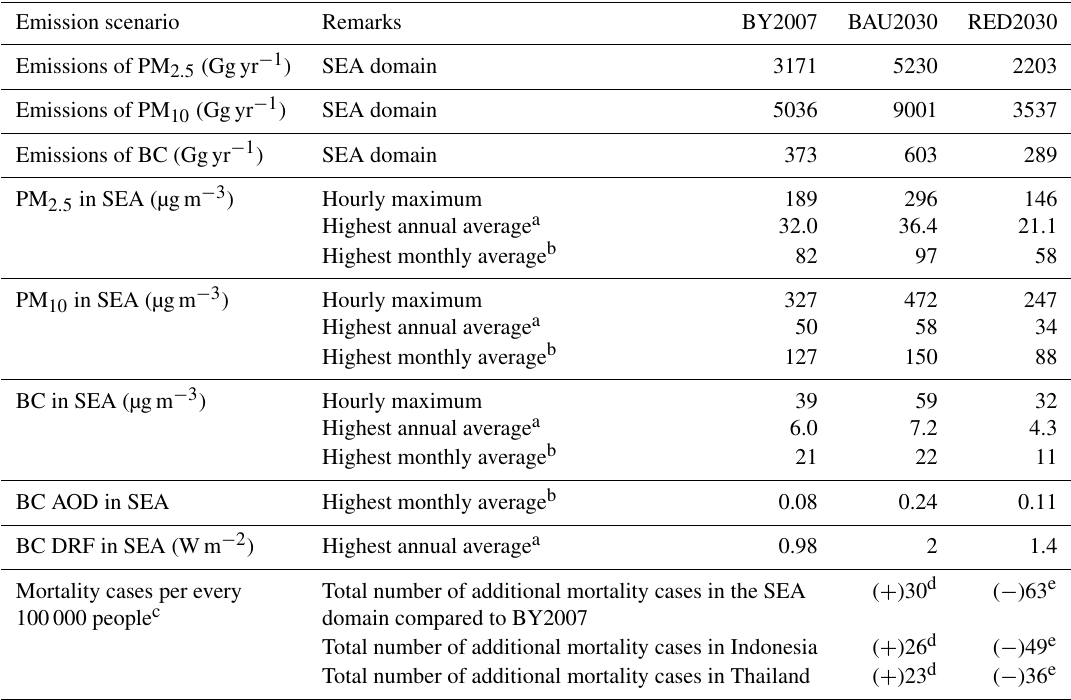
Table 2. Summary of emission reduction scenarios for the SEA domain.